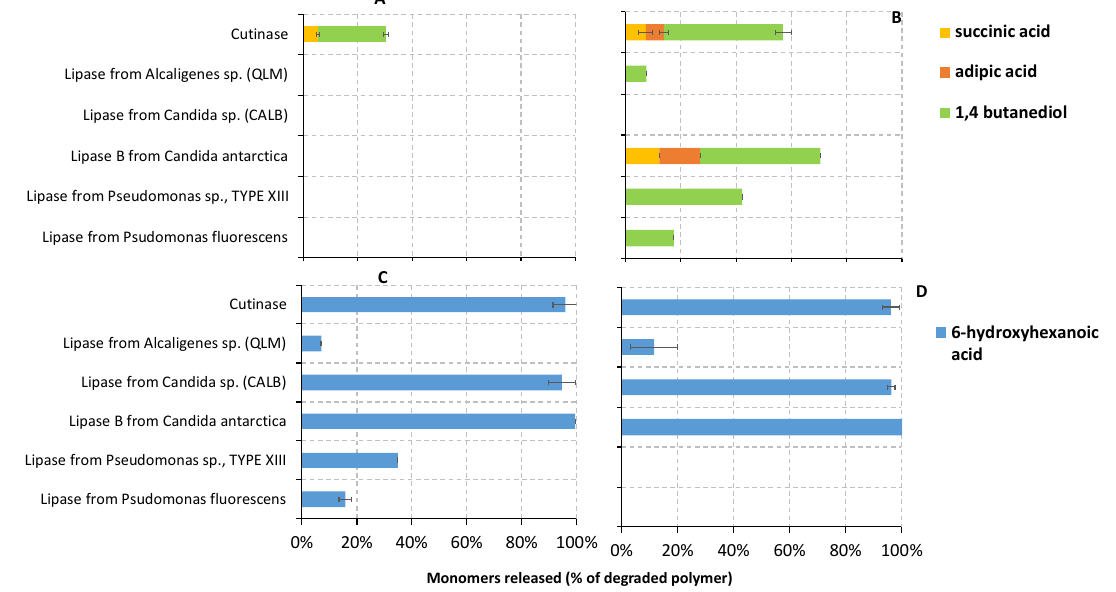
Monomers released (% of degraded polymer) Figure 6. A fraction (%) of the degraded PBS ( A ), PBSA ( B ), PCL6500D ( C ), and PCL6800D ( D ) films which have been hydrolyzed into monomers by several enzymes in the last sampling time. No monomers were detected in the negative enzyme-free controls (data not shown), according to the negligible or absent abiotic hydrolysis occurring on polyesters films when incubated in a buffer solution without enzymes. Conversely, the total monomer concen- tration (mmol/L) of PBS (SA and BD), PBSA (SA, AA and BD), PCL6500D and PCL6800D (HA) samples treated with the different enzymes tends to increase linearly over time (Fig- ure 5). Actually, the weight loss of PBS treated with cutinase (approximately 63%) at the end of incubation was much greater than the total monomer concentration quantified in the last liquid fraction, corresponding to approximately 30.5% of the degraded PBS (Fig- ure 6). Therefore, it can be assumed that PBS weight loss was initially caused by a release of many oligomers, which were further hydrolyzed into monomers as polymer degrada- tion proceeded. This agrees with GPC data, which revealed the presence of dimers in the liquid fraction. Based on these results, a prevalent endo-type mechanism might be sug- gested for the hydrolysis of PBS by cutinase. Moreover, the concentration of BD was higher than that of SA (Figure S9) at each sampling time; for example, the fraction of the degraded polymer that was hydrolyzed into BD and SA corresponded to approximately 25 and 5%, respectively, after 4 h incubation (Figure 6A). This would indicate that cutinase cuts the polyester chain mainly from the OH-ends. Shi et al. (2019)[20] also suggested an endo-type mode of action for cutinase on PBS, since they observed SA monomer and short chain oligomers as the main degradation products; however, they did not find BD mono- mer during enzymatic degradation, indicating that cutinase cuts the polymer chain from the carboxyl end. On the contrary, Lee et al. [19] proposed an exo-type mechanism for the hydrolysis of PBS by lipase from Pseudomonas cepacia, since 4-hydroxybutyl succinate di- mer was detected as the main degradation product. Li et al. [67] also revealed succinic acid and succinates rather than PBS oligomers and BD monomers as PBS degradation products, indicating an exo-type action mode and a carboxyl end cleaving for the PBS- degrading enzyme from A spergillus sp. In the case of PBSA, no monomers were detected in the samples treated with lipase from Candida sp. (CALB), according to the negligible weight loss of PBSA film which oc- curred in this sample. Conversely, faster and greater total monomer concentration was detected in the samples treated with cutinase, lipase from Pseudomonas sp. and lipase B